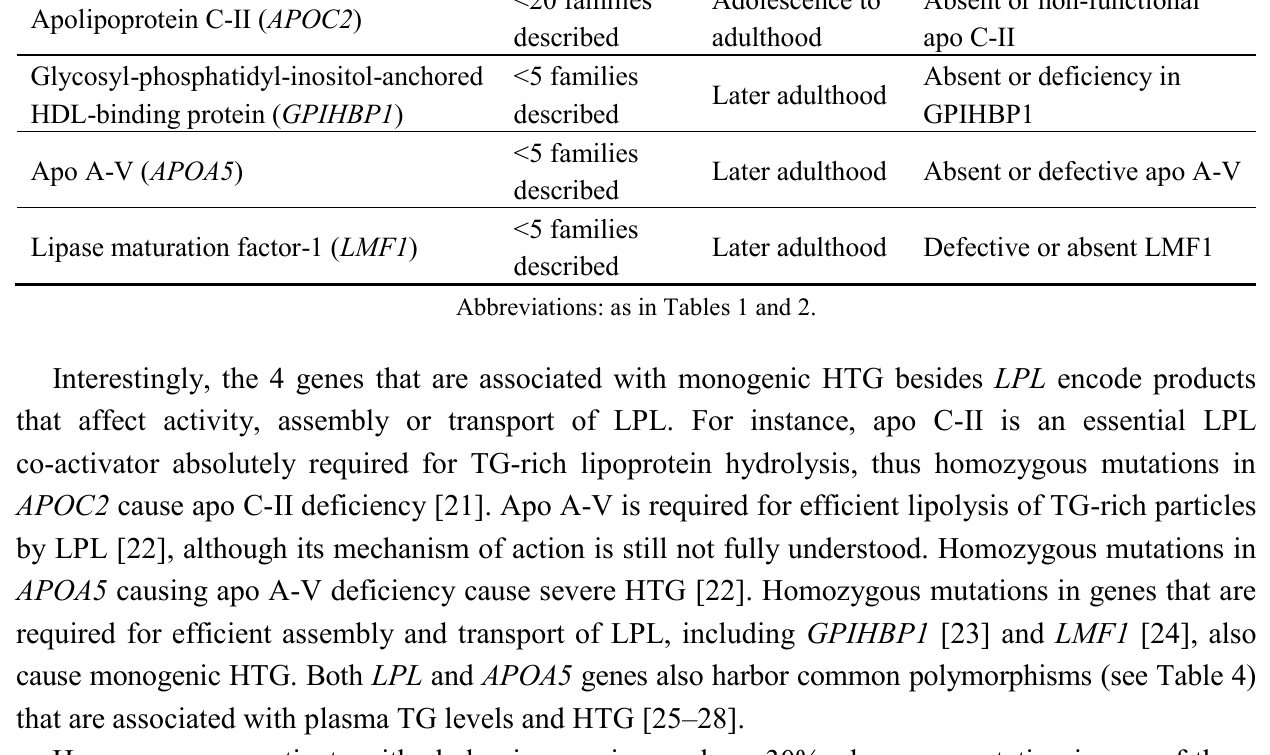
Disease Age of onset Molecular basis prevalence 1 in 1 million Infancy or (95% of cases) described